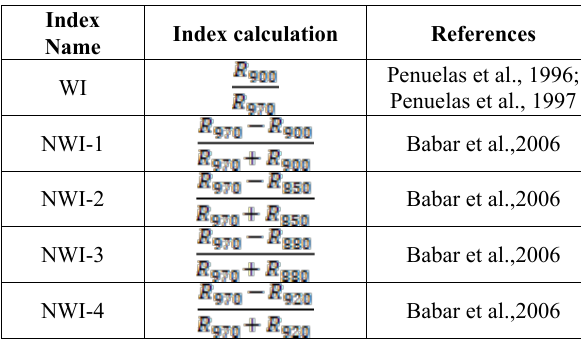
Table 4.Remote sensing Indices for water content